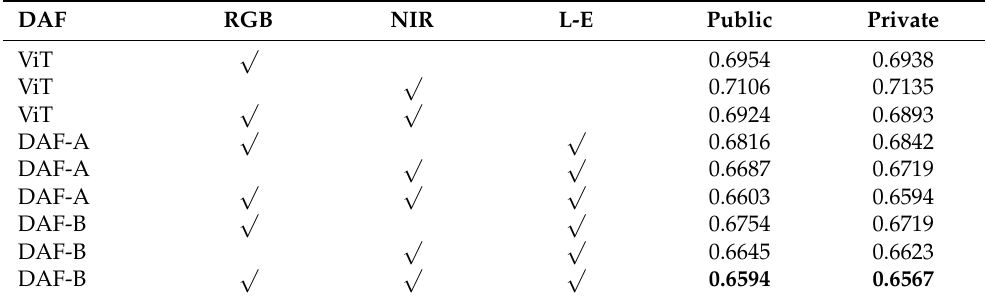
Table 5. Comparisons between different DAF models. RGB”, “NIR”, and “L-E” indicate the input feature type for the RGB path, NIR path, and multimodal location environment